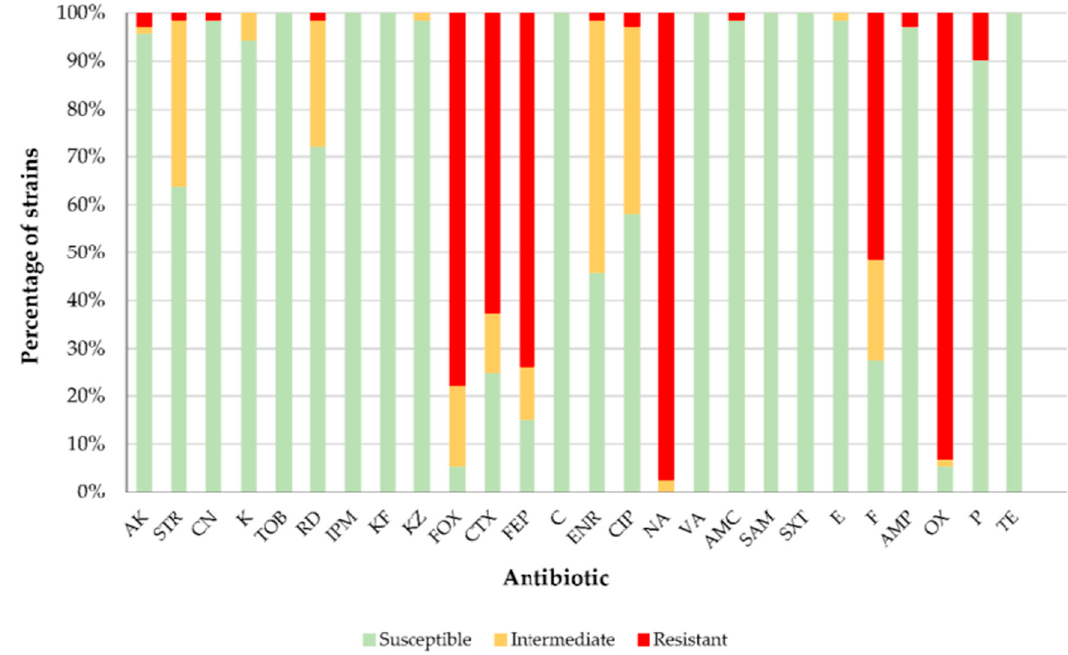
Figure 2. Percentage of L. monocytogenes isolates ( n = 72) from red meat and poultry susceptible (S), intermediate (with reduced susceptibility; I) and resistant (R) to antibiotics. Amikacin (AK), streptomycin (STR), gentamycin (CN), kanamycin (K), tobramycin (TOB), rifampicin (RD), imipenem (IPM), cephalothin (KF), cefazolin (KZ), cefoxitin (FOX), cefotaxime (CTX), cefepime (FEP), chloramphenicol (C), enrofloxacin (ENR), ciprofloxacin (CIP), nalidixic acid (NA), vancomycin (VA), amoxicillin-clavulanic acid (AMC), sulbactam-ampicillin (SAM), trimethoprim-sulfamethoxazole (SXT), erythromycin (E), nitrofurantoin (F), ampicillin (AMP), oxacillin (OX), penicillin (P), tetracycline (TE).